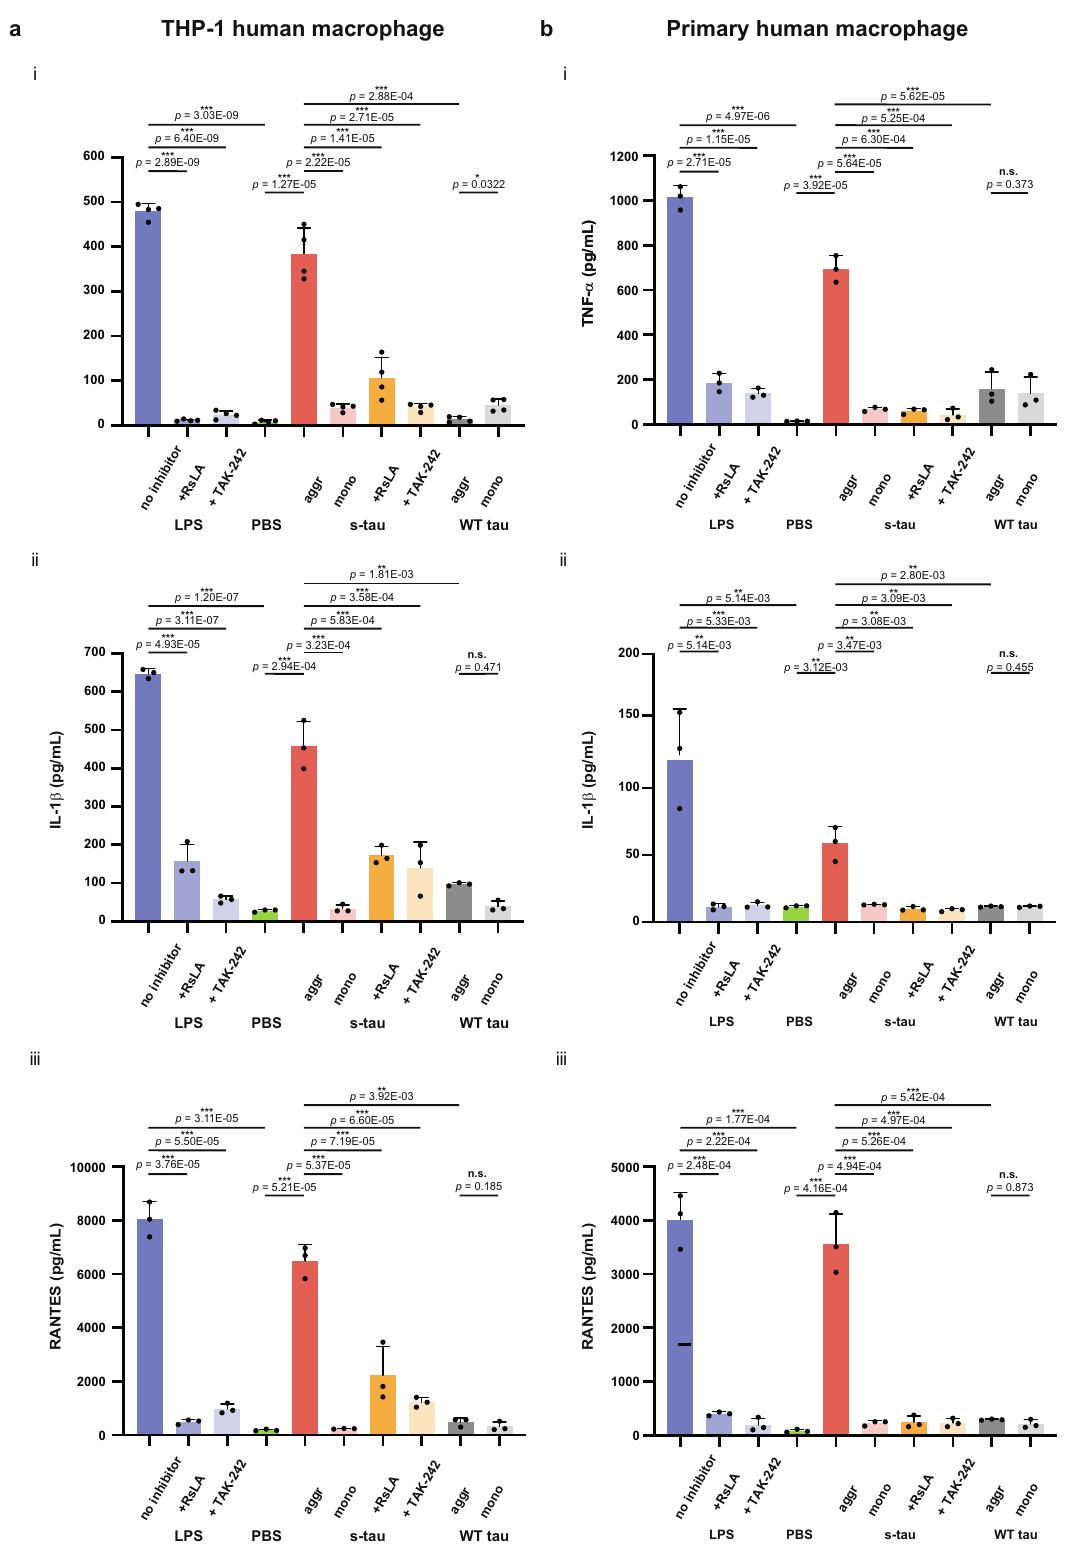
Fig. 5 Hyperphosphorylated tau aggregates induced signi fi cantly higher levels of all three pro-in fl ammatory cytokines than heparin-induced WT aggregates. (i) TNF-a, (ii) IL-1 β , and (iii) CCL5 ELISA assays were conducted on both a THP-1 human macrophage cells and b primary human macrophage cells to determine the pro-in fl ammatory responses mediated treatment by LPS, s-tau monomer or aggregates or heparin-induced WT aggregates or its monomeric control with or without the TLR4 antagonists RsLA or Tak-242. LPS and PBS served as the positive and negative controls. The P -values are based on unpaired two-sided Student ’ s t -test: ** p < 0.01, *** p < 0.001, n.s. non-signi fi cant. Data are presented as mean values ± s.d. of three independent experiments except for a -(i) which had four independent experiments. Source data are provided as a Source Data fi